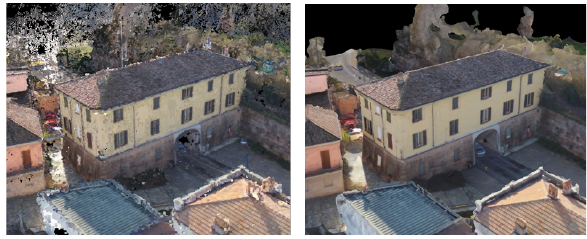
Figure 7. Circular flight, point cloud (left) and mesh (right)